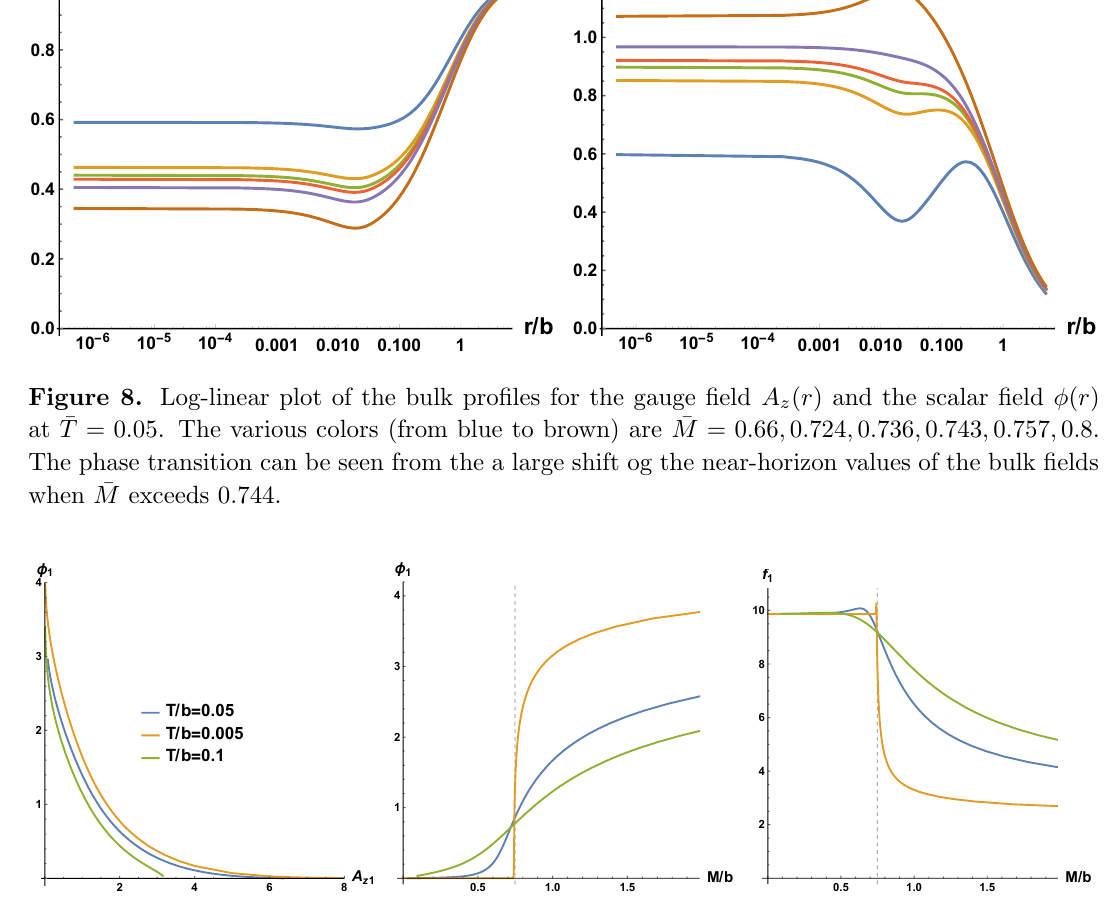
Figure 9. Numerical details for the results presented in the main text for (cid:22) T = 0 : 1 ; 0 : 05 ; 0 : 005. Left: the values of ( A z ; (cid:30) 1 ) for the horizon shooting. Center: the value of (cid:30) 1 in function of (cid:22) M . 1 Right: the value of f 1 in function of (cid:22) M